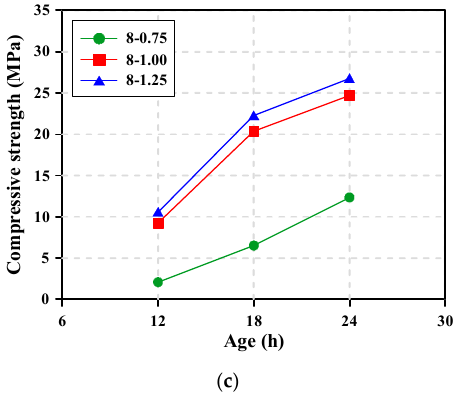
Figure 10 . Compressive strength development of AAS mortar specimens cured in a chamber at 20 °C: ( a ) Na 2 O content = 4%, ( b ) Na 2 O content = 6%, ( c ) Na 2 O content = 8%